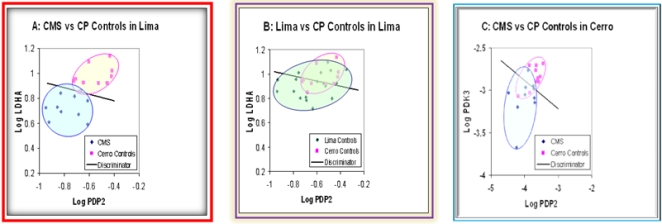
Niche (scatter) plots of genes that best predict the presence of CMS in Peruvian altitude dwellers.Because LDHA was not assayed at altitude it was substituted by PDK3 which was highly correlated with LDHA. A: CMS vs CP Controls in Lima (normoxia). B: Lima Controls vs CP Controls in Lima. C: CMS vs CP Controls in Cerro de Pasco (4338 m,). When hypoxia was shown to have been replaced by short sea level sojourn, normoxia (A), the CMS patients were clearly separated from control altitude dwellers. B. There were no differences between altitude controls and Lima controls in Lima. In Cerro de Pasco the CMS patients and controls were mostly separated by the “discriminator line”. Discriminator line based on discrimination of the two groups by logistic regression. CMS = chronic mountain sickness. LDHA = Lactate dehydrogenase A. PDK3 = . Pyruvate dehydrogenase Kinase3. This kinase is involved in “aerobic glycolysis” (the Warburg effect). It suports a metabolic pattern seen in many (but not all) hypoxia adapted tissue, also in cancer cells and activated immune cells. PDP2 = phosphatase that de-phosphorylates the E1-alpha subunit of pyruvate dehydrogenase. CP = Cerro de Pasco altitude 4338 m. Cerro = Cerro de Pasco. Con = Andean controls. H = high altitude. L = Low altitude